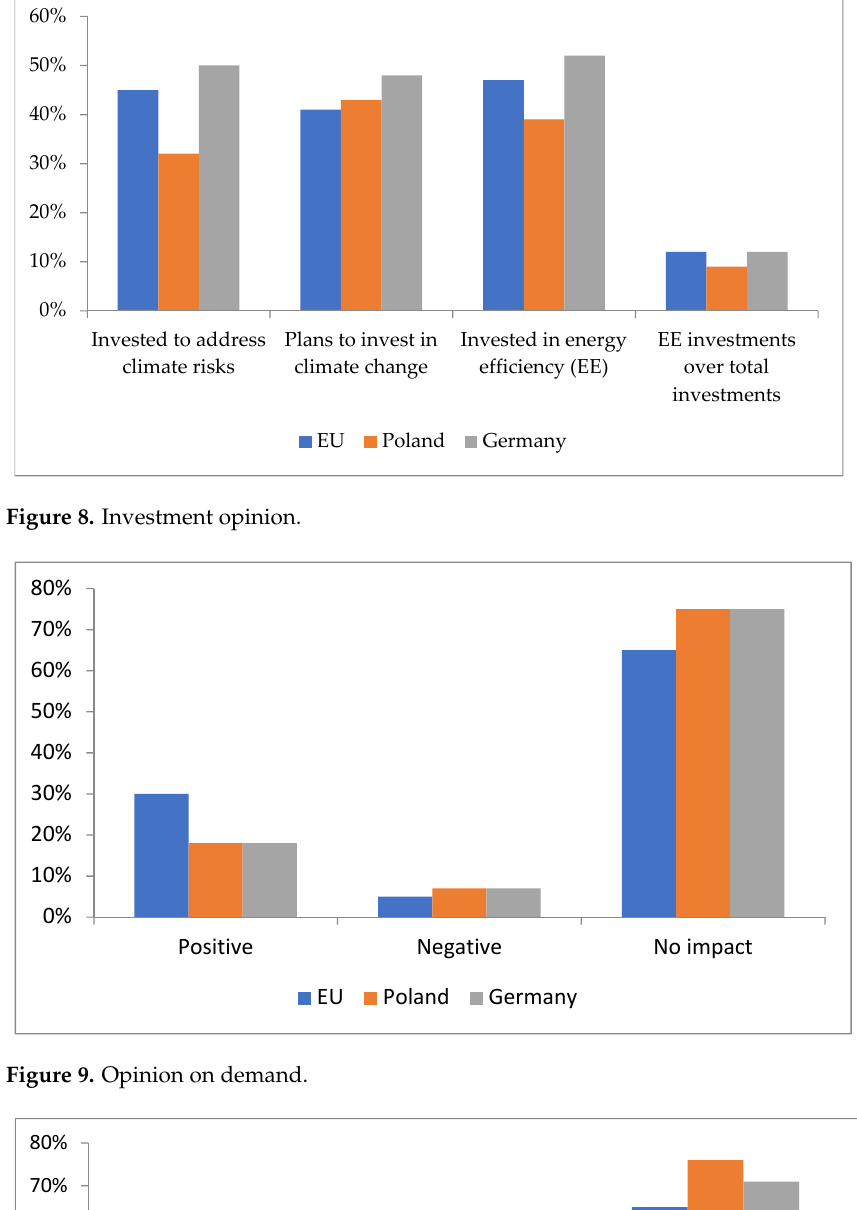
Figure 9. Opinion on demand.